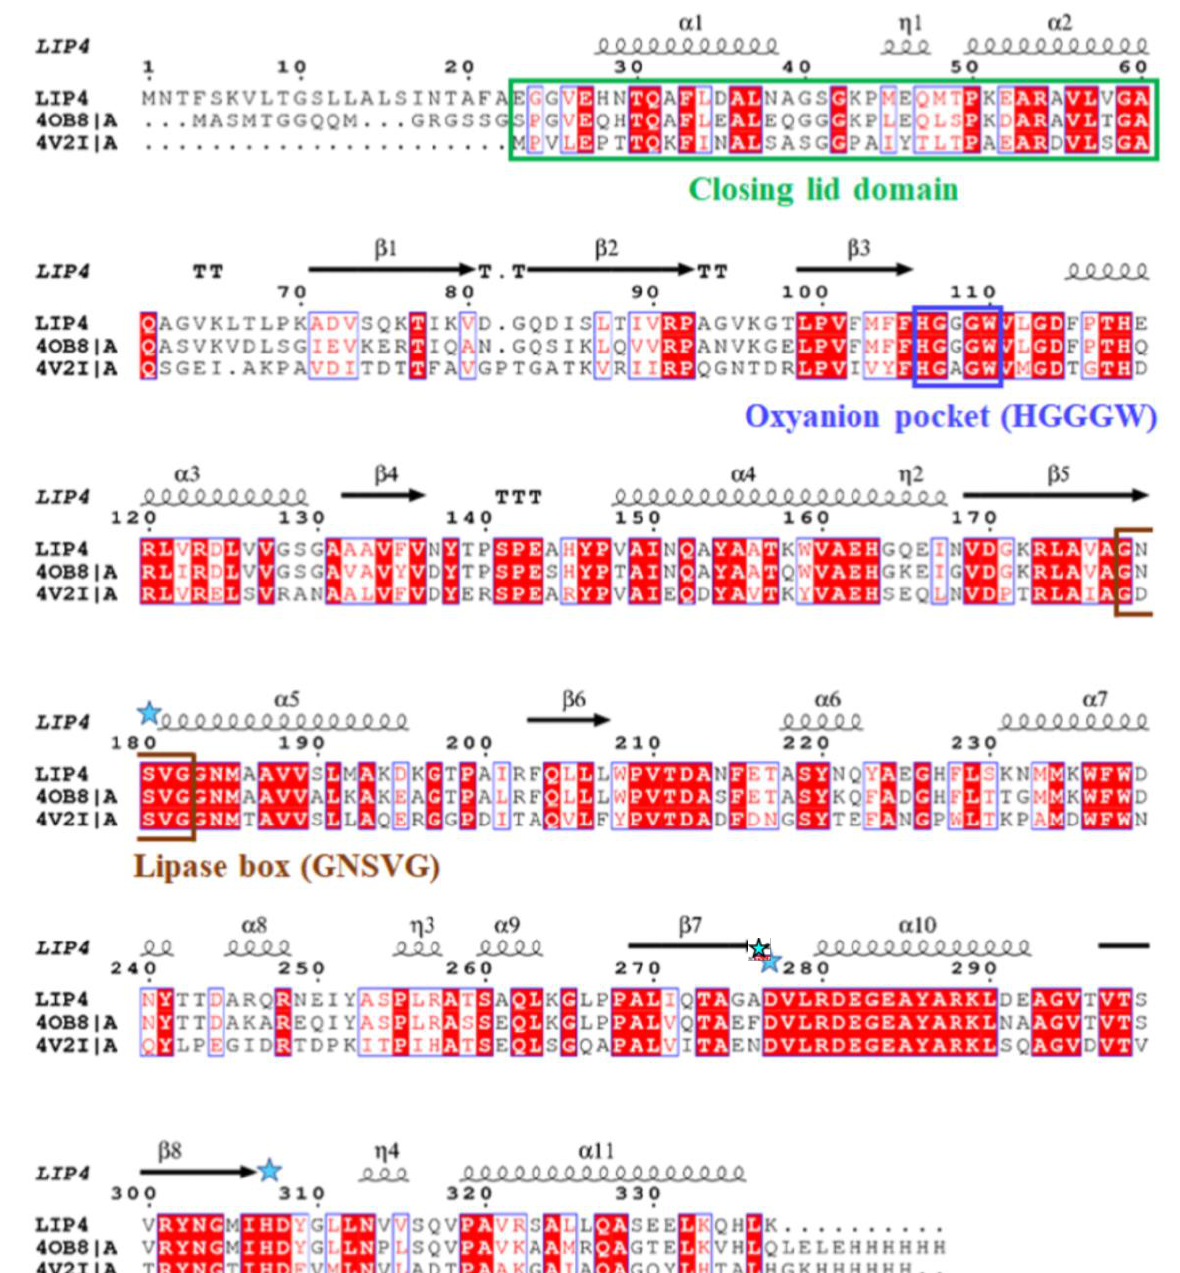
Figure 4. Amino acid sequence alignment of LIP4 with the alpha/beta hydrolase fold-3 domain protein from Pseudomonas sp. ECU1011 (4OB8) and lipase of Thalassospira sp. GB04J01 (4V2I). Brown box: amino acids of the consensus sequence of the lipase box; blue box: amino acid residues of the oxyanion hole; green box: amino acid residues of the closing lid domain; blue asterisks: the positions of the amino acids of the catalytic triad (serine, glutamic acid, and histidine) in the sequence; the secondary structure segments of the α -helix and the β -sheet are shown alone at the top of the alignment. White letters with red highlights represent amino acid residues that are conserved in all the enzyme sequences and red letters in blue frame indicate conserved regions with identical amino acid residues (residues with similar properties) in one or two of the enzyme sequences.